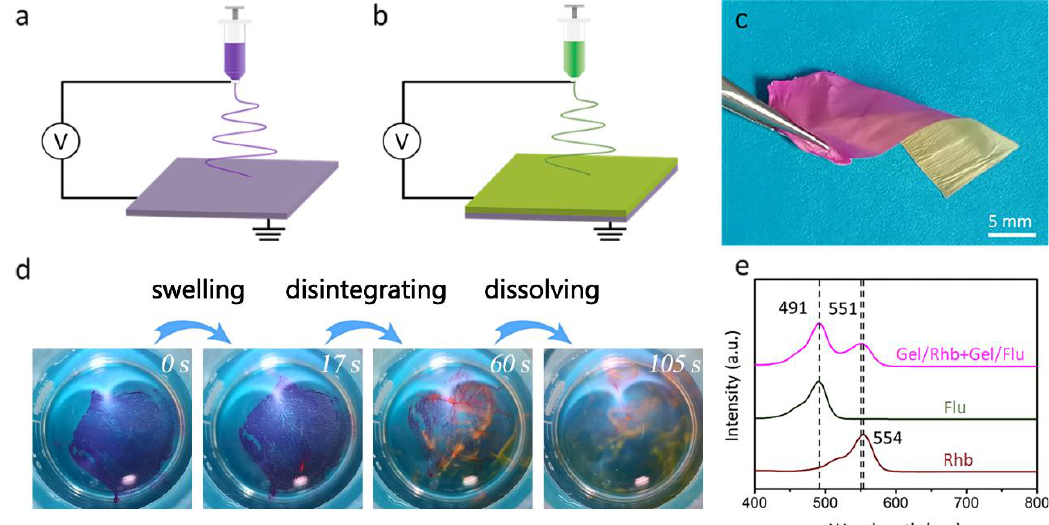
Figure 4. ( a , b ) Schematic illustration of the sequential electrospinning approach used to fabricate the dual drug-loaded bilayered gelatin nanofibrous membrane. ( c ) Digital image of the obtained dual drug-loaded nanofibrous membrane. ( d ) Fast-dissolving process of the dual drug-loaded bilayered gelatin nanofibrous membrane. ( e ) UV-Vis absorption spectra of Rhb solution, Flu solution, and the solution after dissolving the dual drug-loaded nanofibrous membrane.